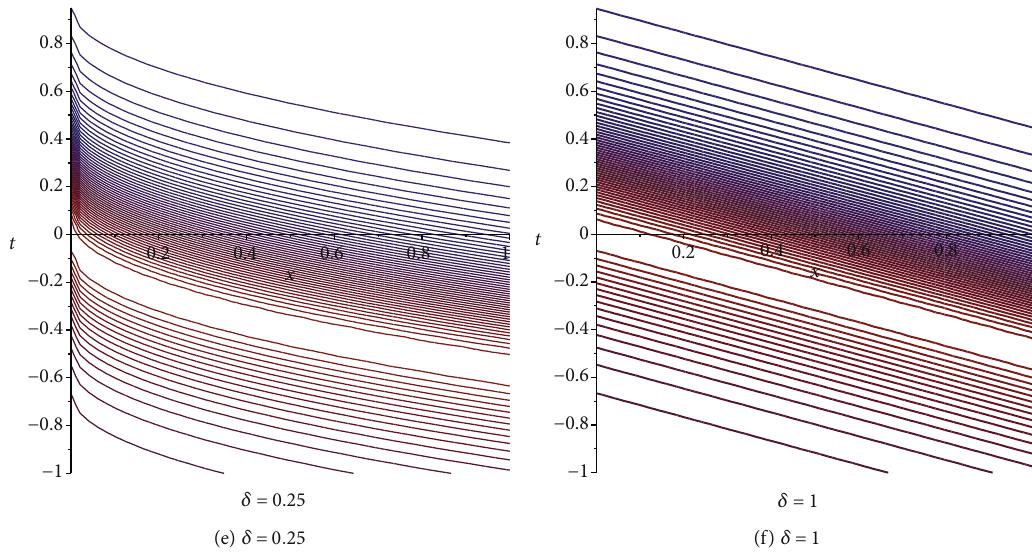
Figure 1: Topological kink-dark bell wave for m straight surface for complete order, (d, e, f) corresponding contour plots of beyond.